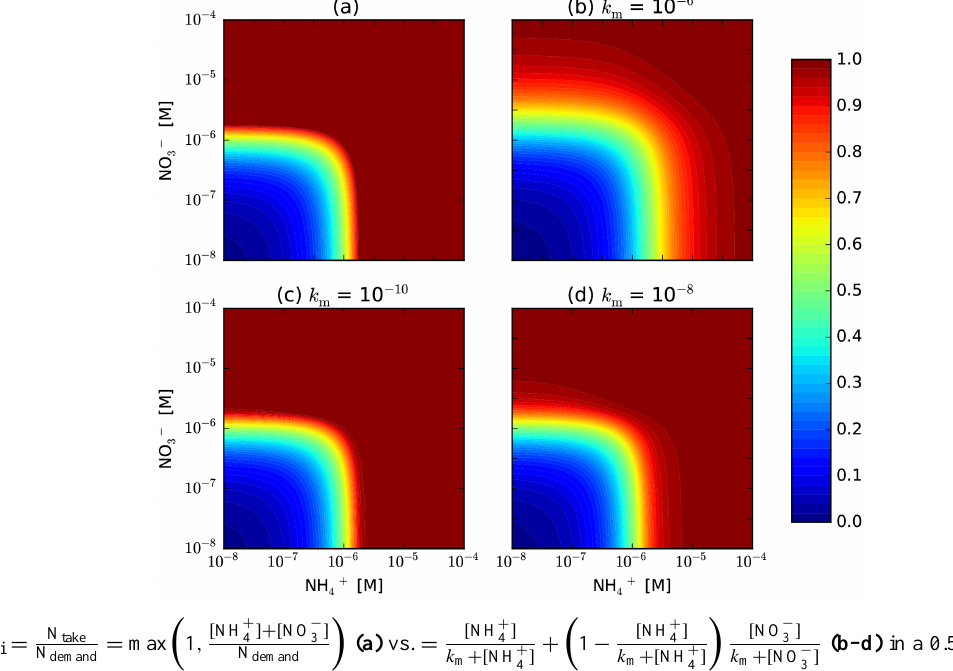
Figure 3. f pi = N take uptake rate of 10 − 9 Ms − 1 . f pi for the latter representation is less than or equal to that for the first one. The difference decreases with decreasing half saturation k m